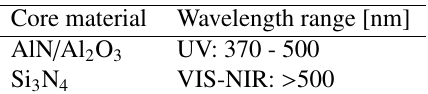
Table 1. Material platforms of waveguides for varying